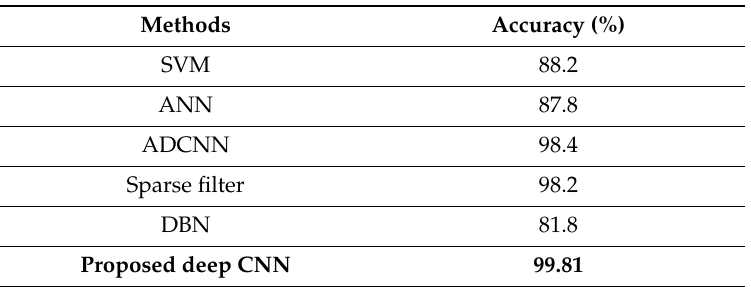
Table 5. Comparison